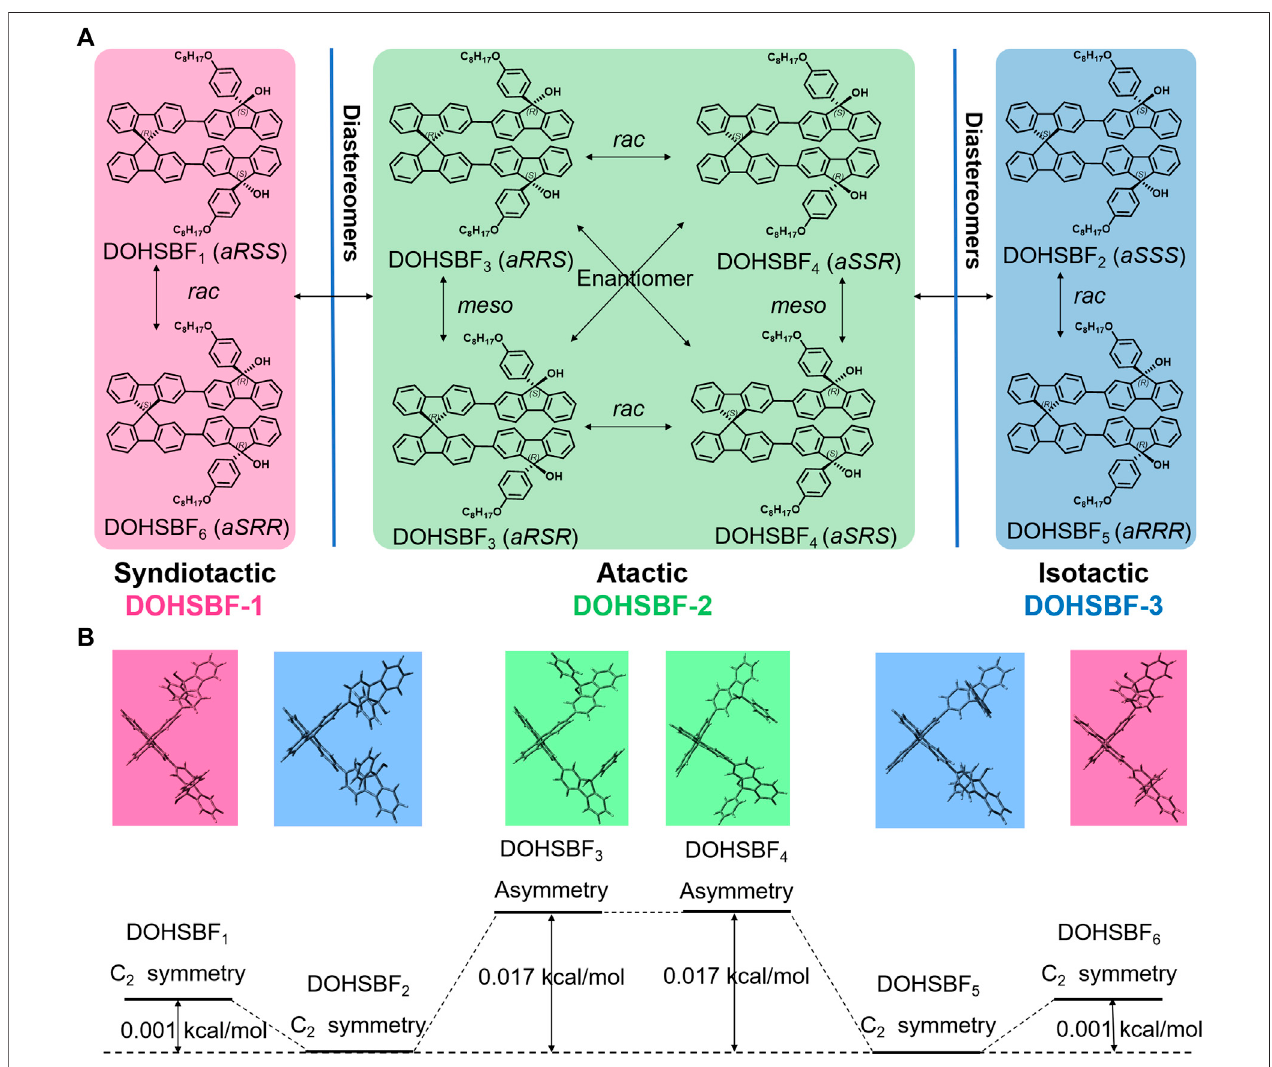
FIGURE 1 | (A) Theoretical con fi gurations of DOHSBF. (B) Energy calculation comparison of possible theoretical stereoisomers of DOHSBF (alkyl chains are omitted) by Gaussian 09 at the B3LYP/6-31G(d) level.